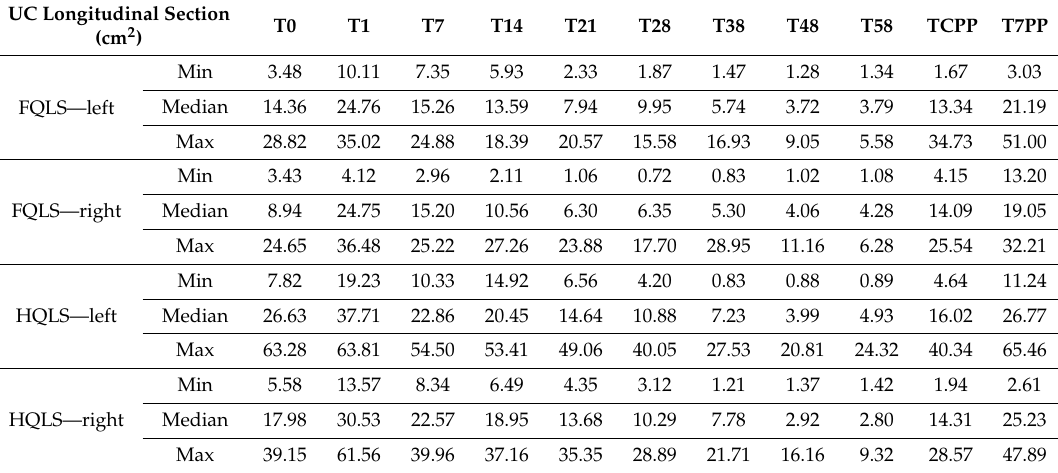
Table 1. The median, maximum (Max) and minimum (Min) values of the size (area) of the udder cistern (UC) for the front (FQ) and hind (HQ) left (-L) and right (-R) quarters in the longitudinal section for T0, T1, T7, T14, T21, T28, T38, T48, T58, T colostrum production phase (TCPP) and T 7 days post-partum